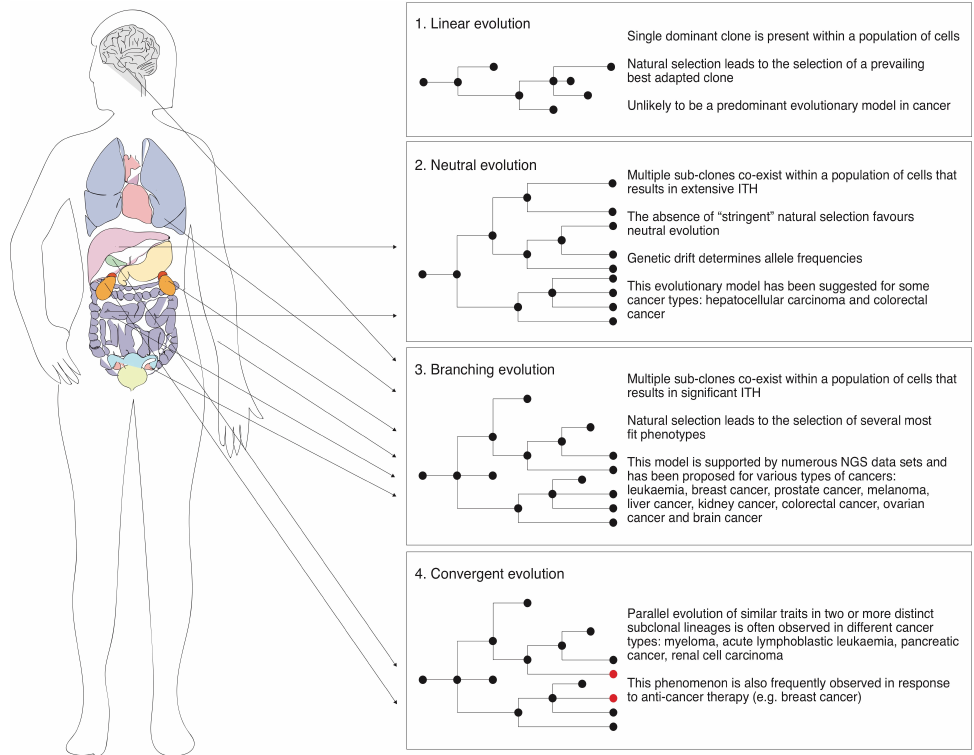
Figure 1. Models of tumour evolution. Scheme summarizing our current knowledge on evolutionary processes taking place in different types of human cancers. Phylogenetic trees depict the relationship among sub-clonal populations over time. Black circles represent nodes of diversification. Red circles depict functional/phenotypic convergence in two genetically distinct